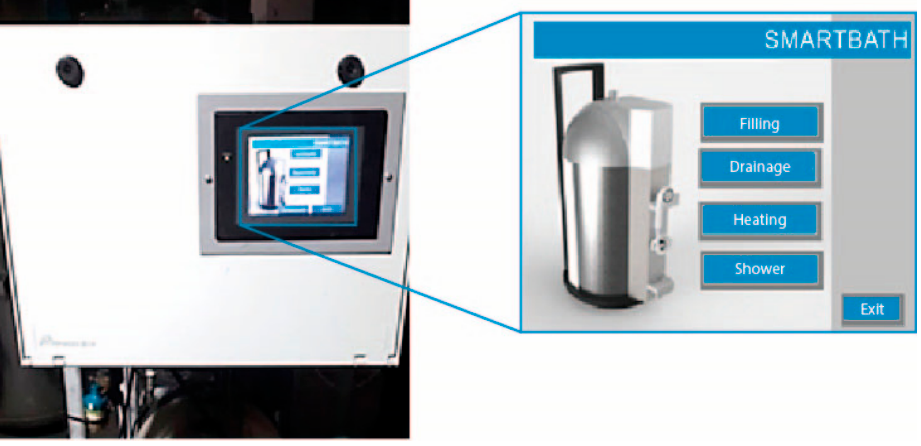
Figure 4. Electronic system and interface (controller).